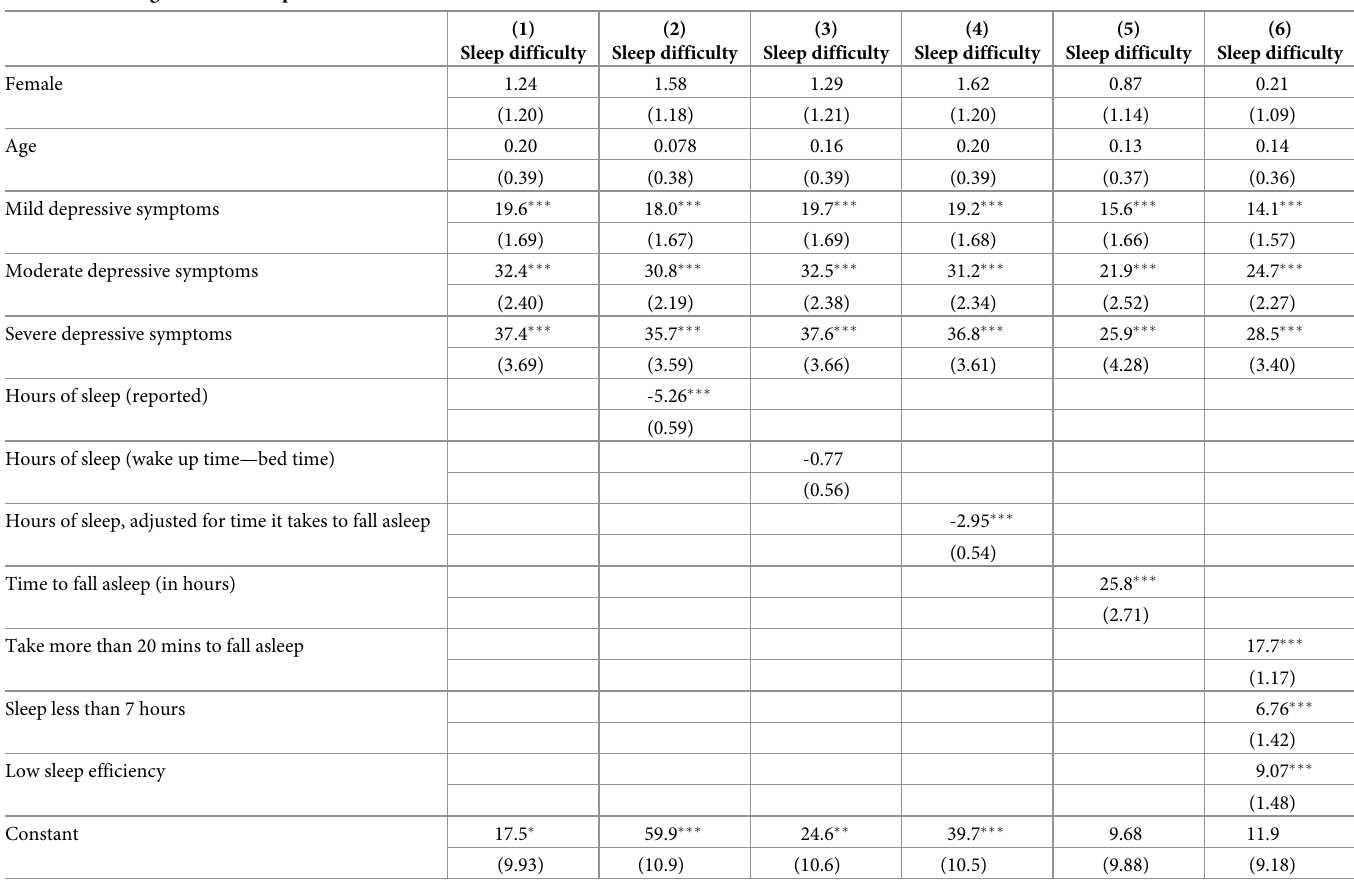
Table 2. Linear regressions of sleep difficulties on our set of control